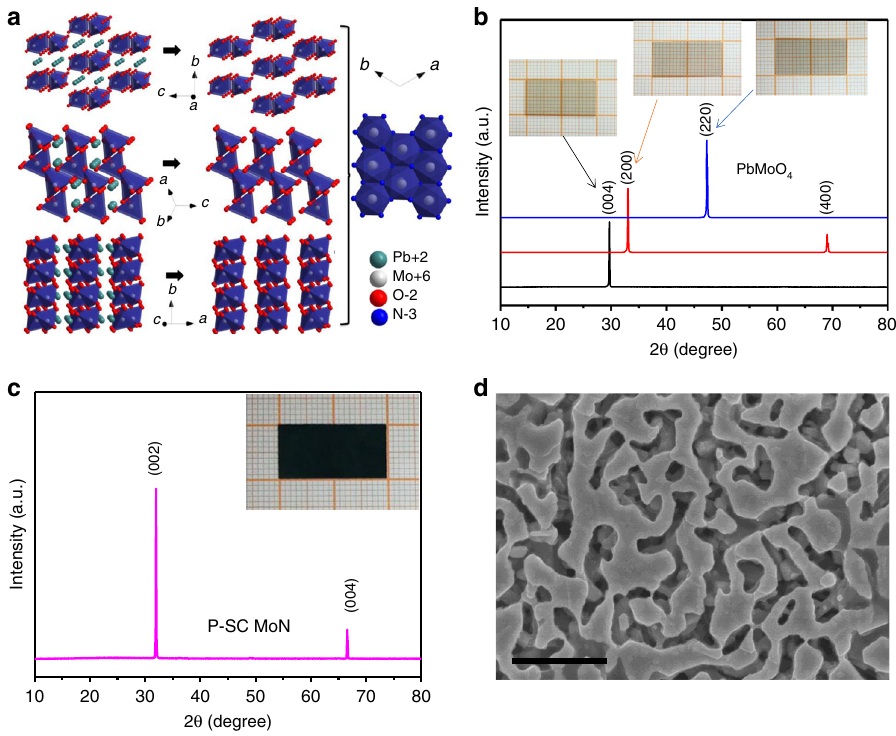
Fig. 1 Growth mechanism and crystal structure. a The growth mechanism of MoN through lattice reconstruction strategy from PbMoO 4 crystals. b The XRD patterns of PbMoO 4 with [001], [100], and [110] facets, the digital images are the parent crystals with dimensions of 20 × 10 × 0.5 mm. c The XRD pattern of MoN grown from PbMoO 4 crystals, the digital images is the metallic porous MoN single crystals with dimensions of 20 × 10 × 0.5 mm. d The porous microstructure of MoN single crystal. The scale bar is 500 nm in panel